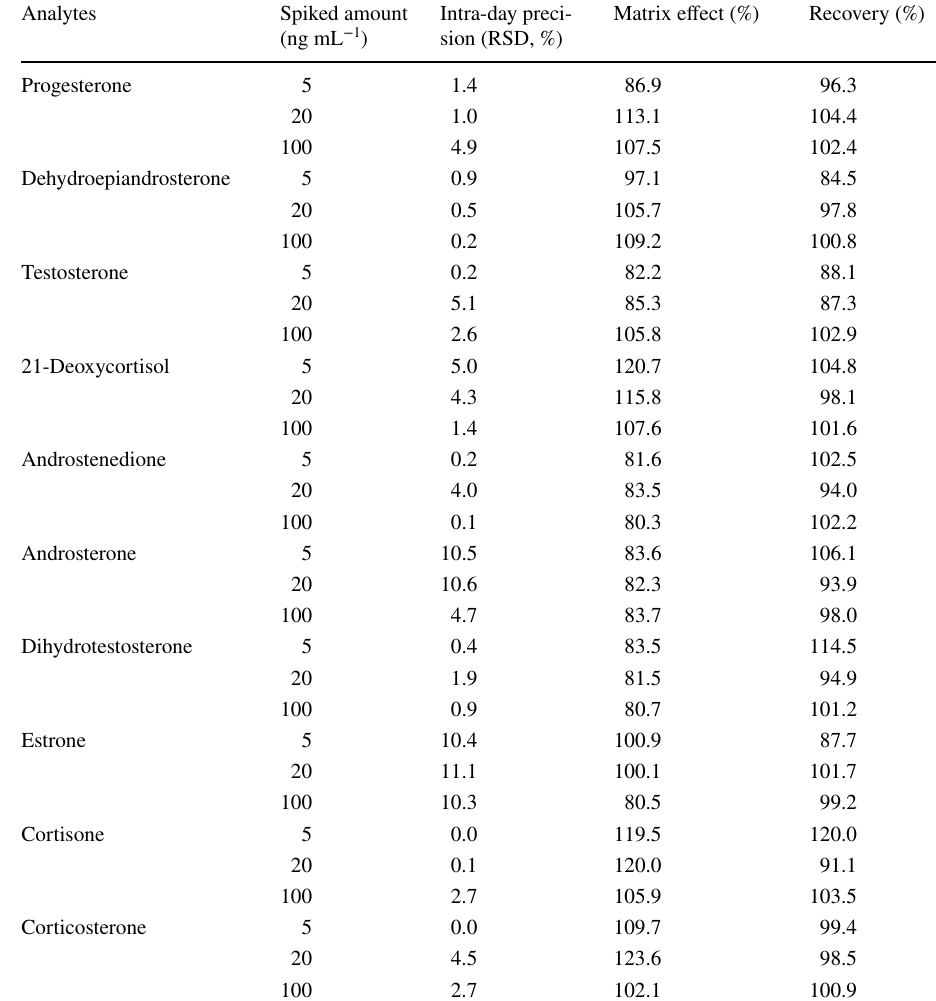
Table 3 Recovery, matrix effect and Intra-day